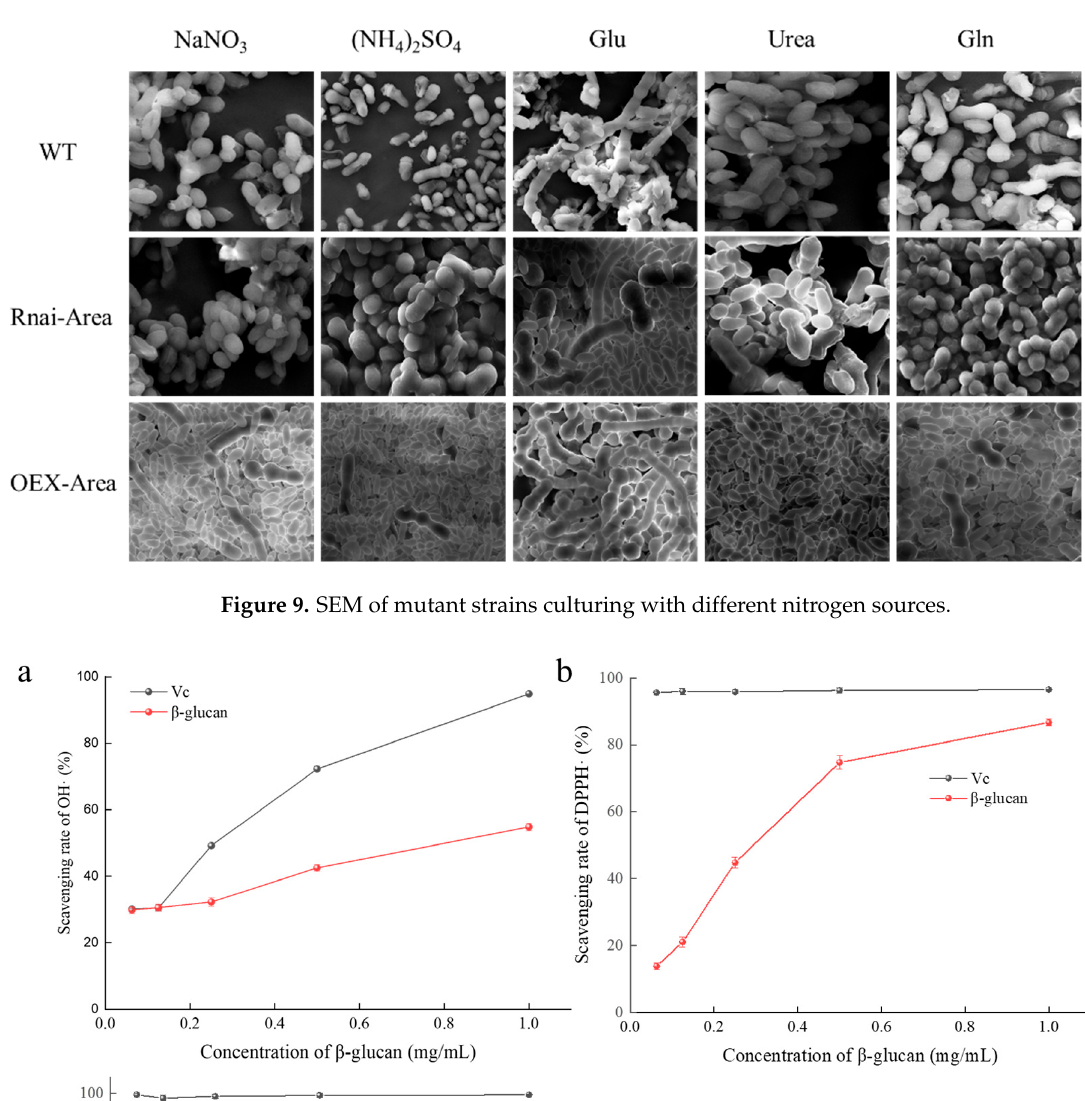
Figure 8. Micromorphology of mutant strains culturing with different nitrogen sources.